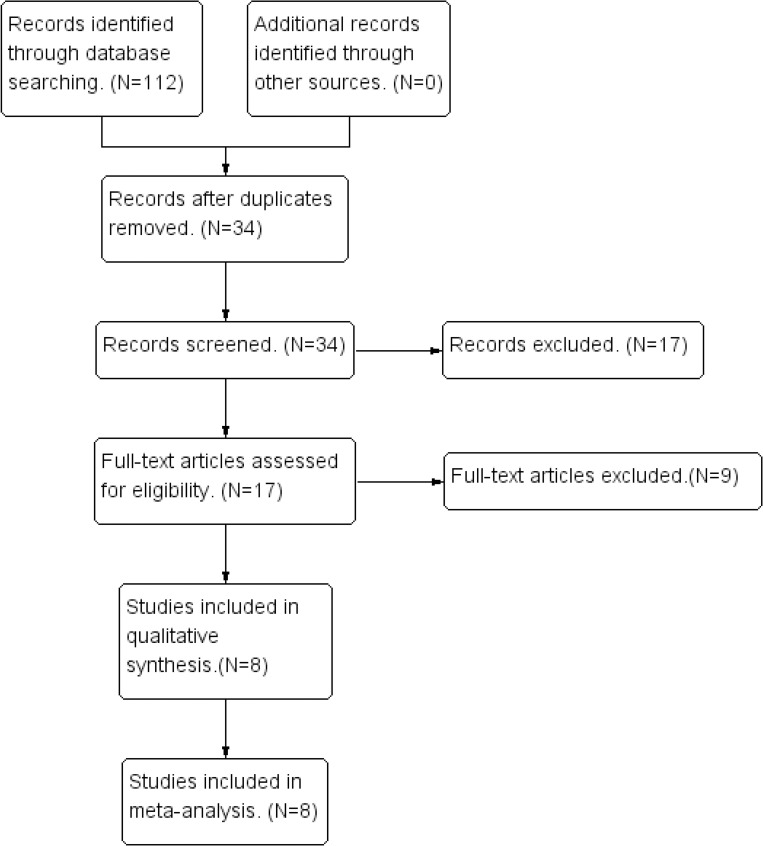
Flow diagram of the search process.